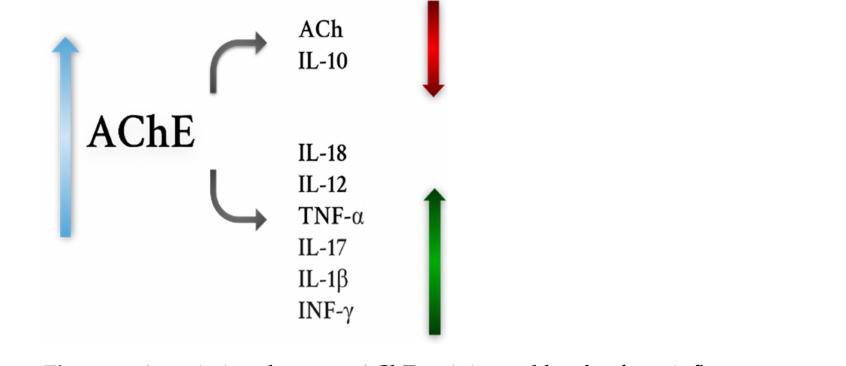
Figure 1. Associations between AChE activity and levels of pro-inflammatory cytokines, ACh levels and anti-inflammatory